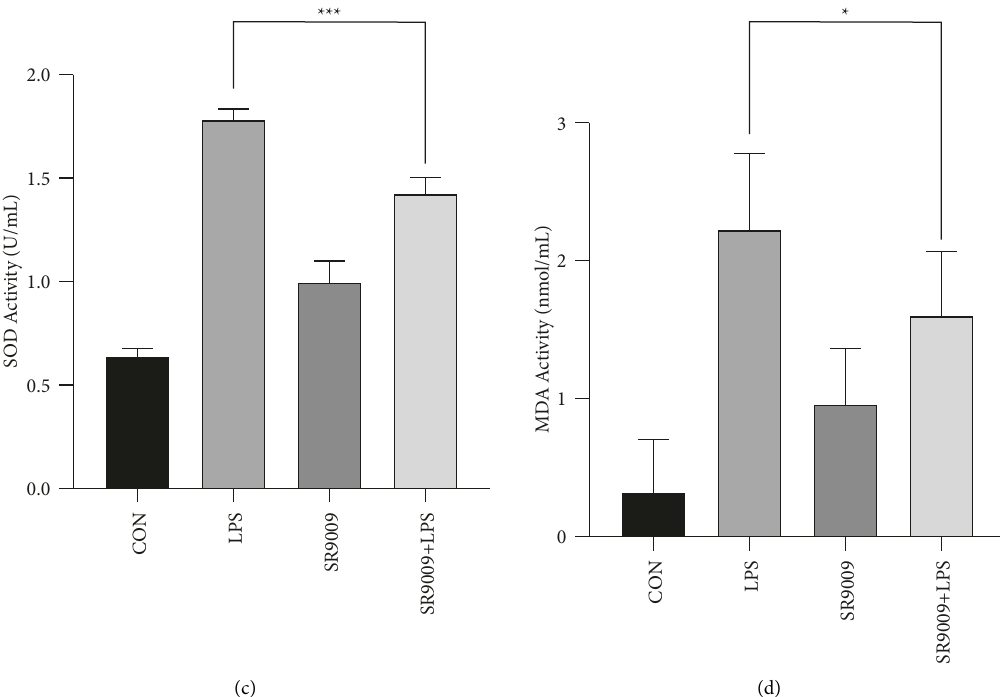
Figure 8: SR9009 alleviates sepsis-induced lung inflammation in mice. The expression levels of T-GSH (a), LD (b), SOD (c), and MDA (d) in lung tissues were detected by ELISA assay. ∗ p < 0 . 05, ∗∗ p < 0 . 01, and ∗∗∗ p < 0 .